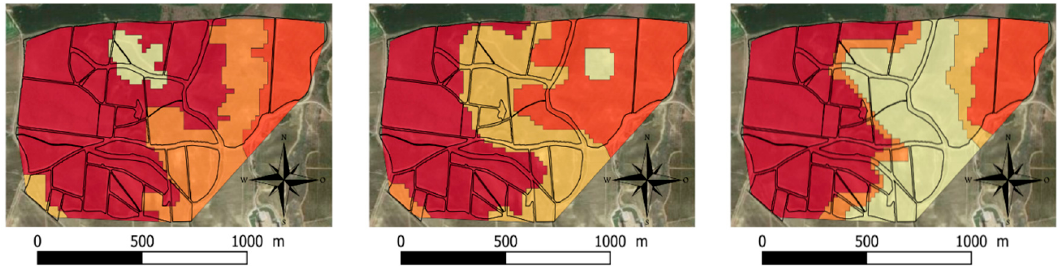
Figure 14. Maps of risk zones of sub-optimal management practices derived in the univariate space with variate specific local expert rules. EC a ( left ); NDVI ( middle ); and Elevation ( right ).